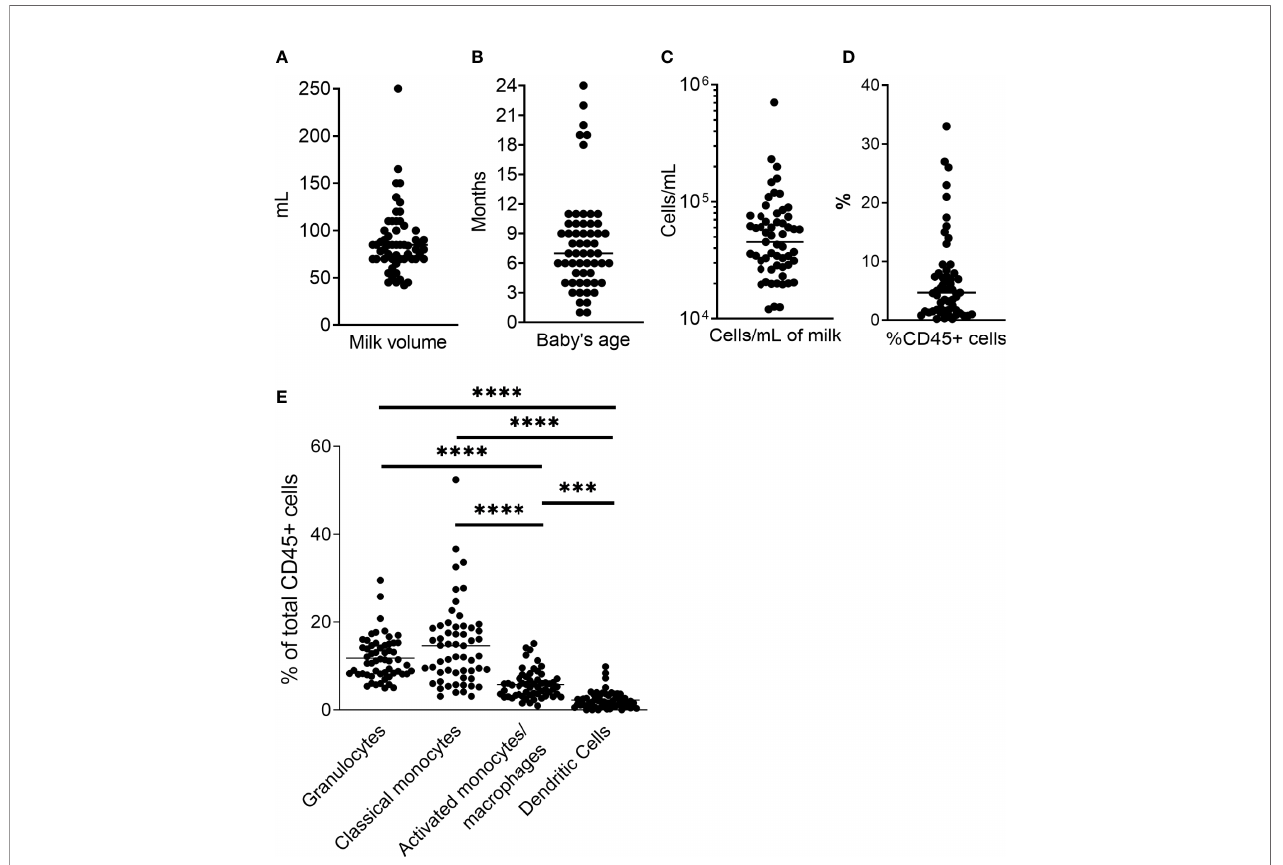
FIGURE 2 | Sample data. (A) Milk volume collected for each sample. Milk was expressed just prior to sample pickup and used within 4h. (B) Baby ’ s age/time post- partum of study participant. (C) Total cell concentration for each sample. Milk was centrifuged at 600 g for 15 min, and cell pellet washed with HBSS at 350g. Cells were counted, and stained as directed (BD). (D) Percent CD45+ cells of total cell population as determined by fl ow cytometry. (E) Phagocyte subset populations expressed as percent of total CD45+ cells. CD45+ cells and phagocyte subsets were identi fi ed as described in Figure 1 . Two-tailed Students ’ t-tests were used to compare phagocyte populations. ***0.0005 ≥ p > 0.0001. ****p = <